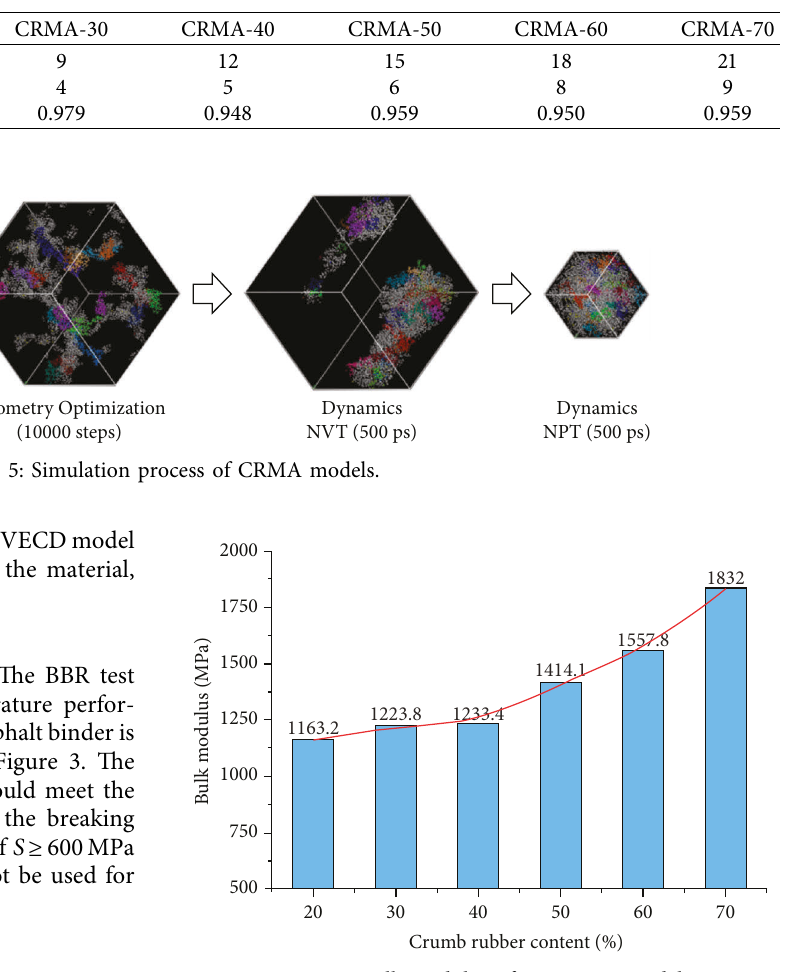
Table 3: Technical parameters of CRMA models.